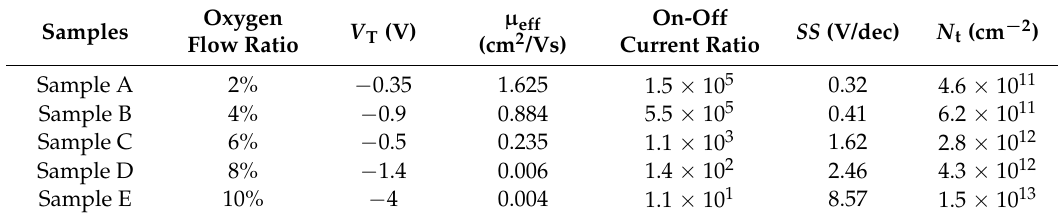
Table 1. Electronic parameters of each unannealed InTiZnO TFT measured in dark at room